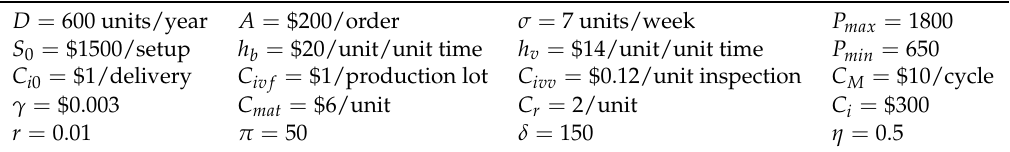
Table 3. Input data for numerical example.